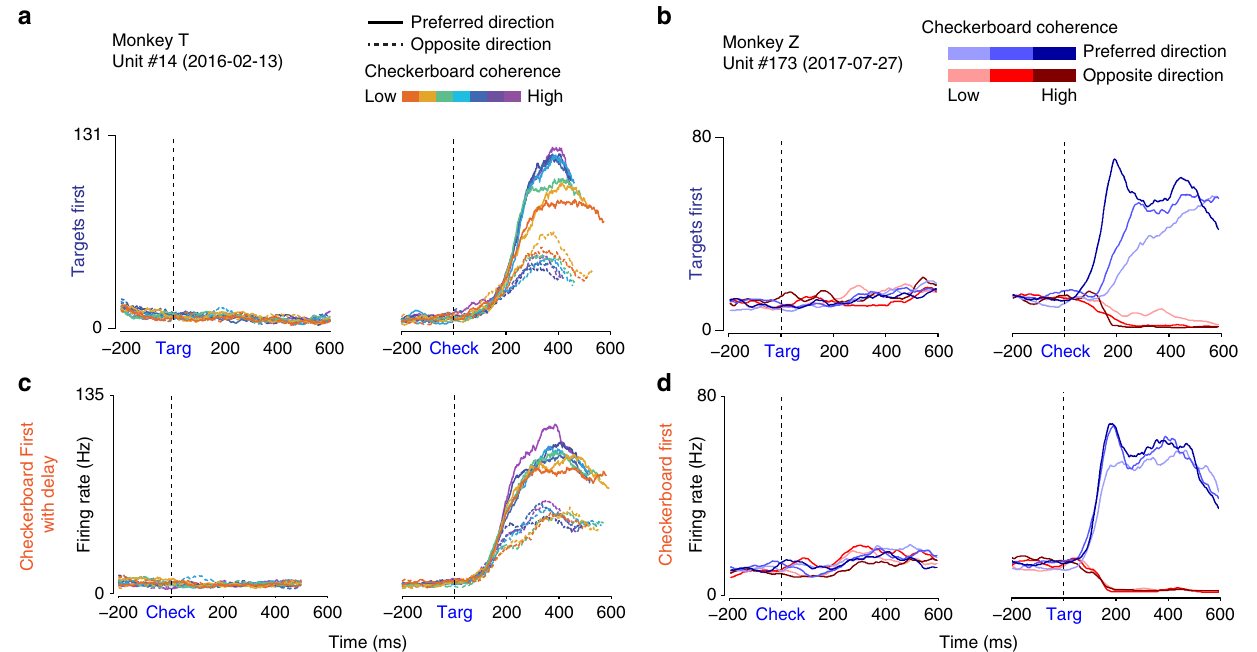
Fig. 2 Example single-unit activity pro fi les in the TF and CF/CFD tasks. Data are aligned to the appearance of the fi rst visual cue (left) and the second visual cue (right) in each task. a , b TF task. Consistent with previous work with similar tasks, the rate of change in neural activity after the appearance of the checkerboard cue (Check) in the TF task correlates with both checkerboard coherence and reach direction. Neither unit responded to the appearance of the fi rst visual cue, the Targets (Targ), in that task. c , d CFD/CF task. In the CF and CFD tasks, the same units show a reduced effect of checkerboard color coherence on the rate of change of activity after the Targets appear. The unit from T showed no change in activity during the initial Checkerboard- observation period of the CF task, but the unit from Z showed a small rapid response change, that was detected 280 ms after Checkerboard appearance (see